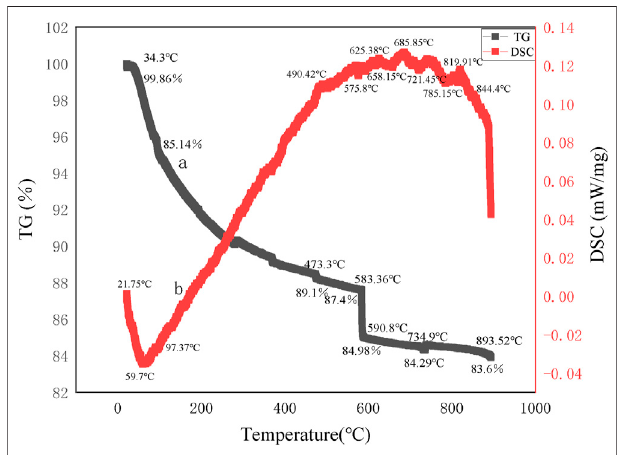
FIGURE9 | The synthesis temperature was70 ° Cand theSi/Al ratio was 10:1.